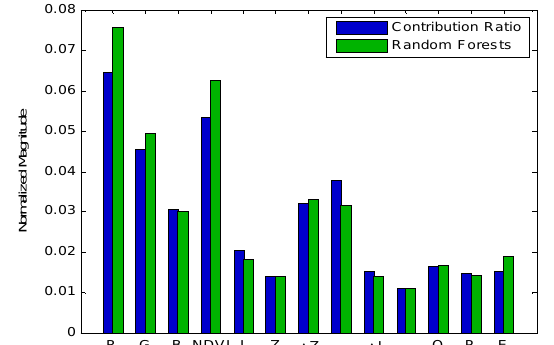
Figure 4: Feature relevance results of Contribution Ratio and Random Forests for dataset Vaihingen.